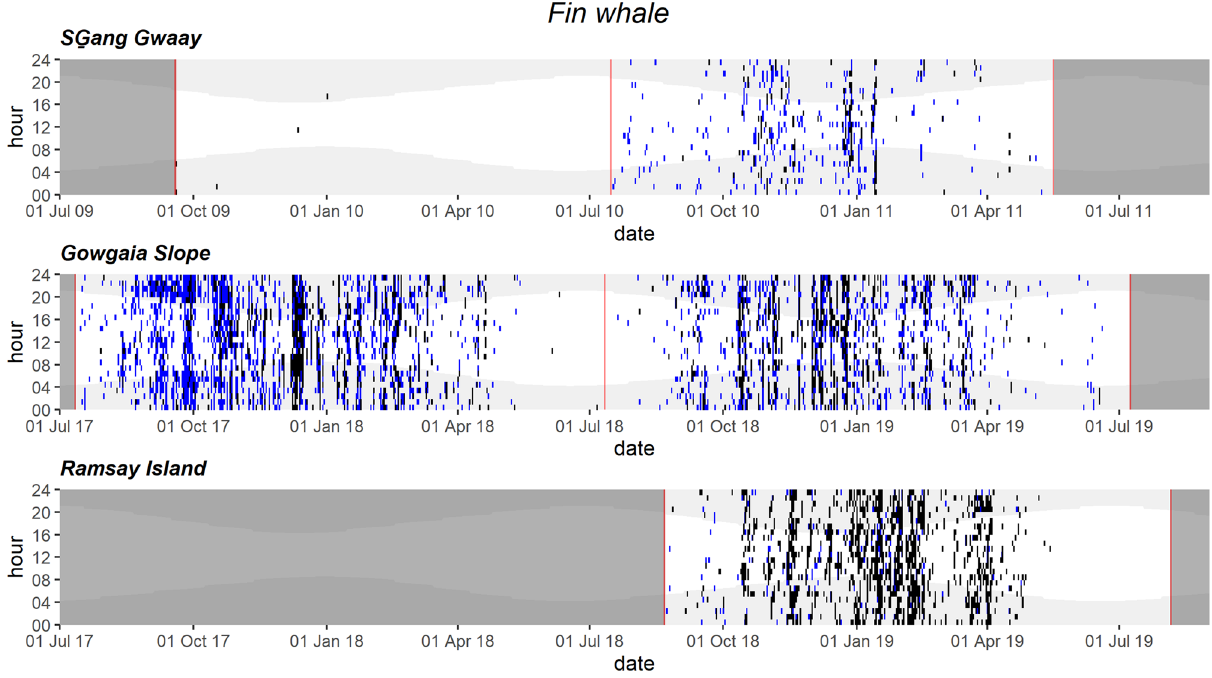
Figure 5. Daily and hourly occurrence of fin whale vocalizations at SG ̱ ang Gwaay, Gowgaia Slope and Ramsay Island in 1-h bins. Blue dots indicate automated detections. Black dots indicate confirmed occurrence. Red lines indicate recorder deployment and retrieval dates. Dark grey areas indicate a lack of recordings. Light grey shaded areas indicate hours of darkness.